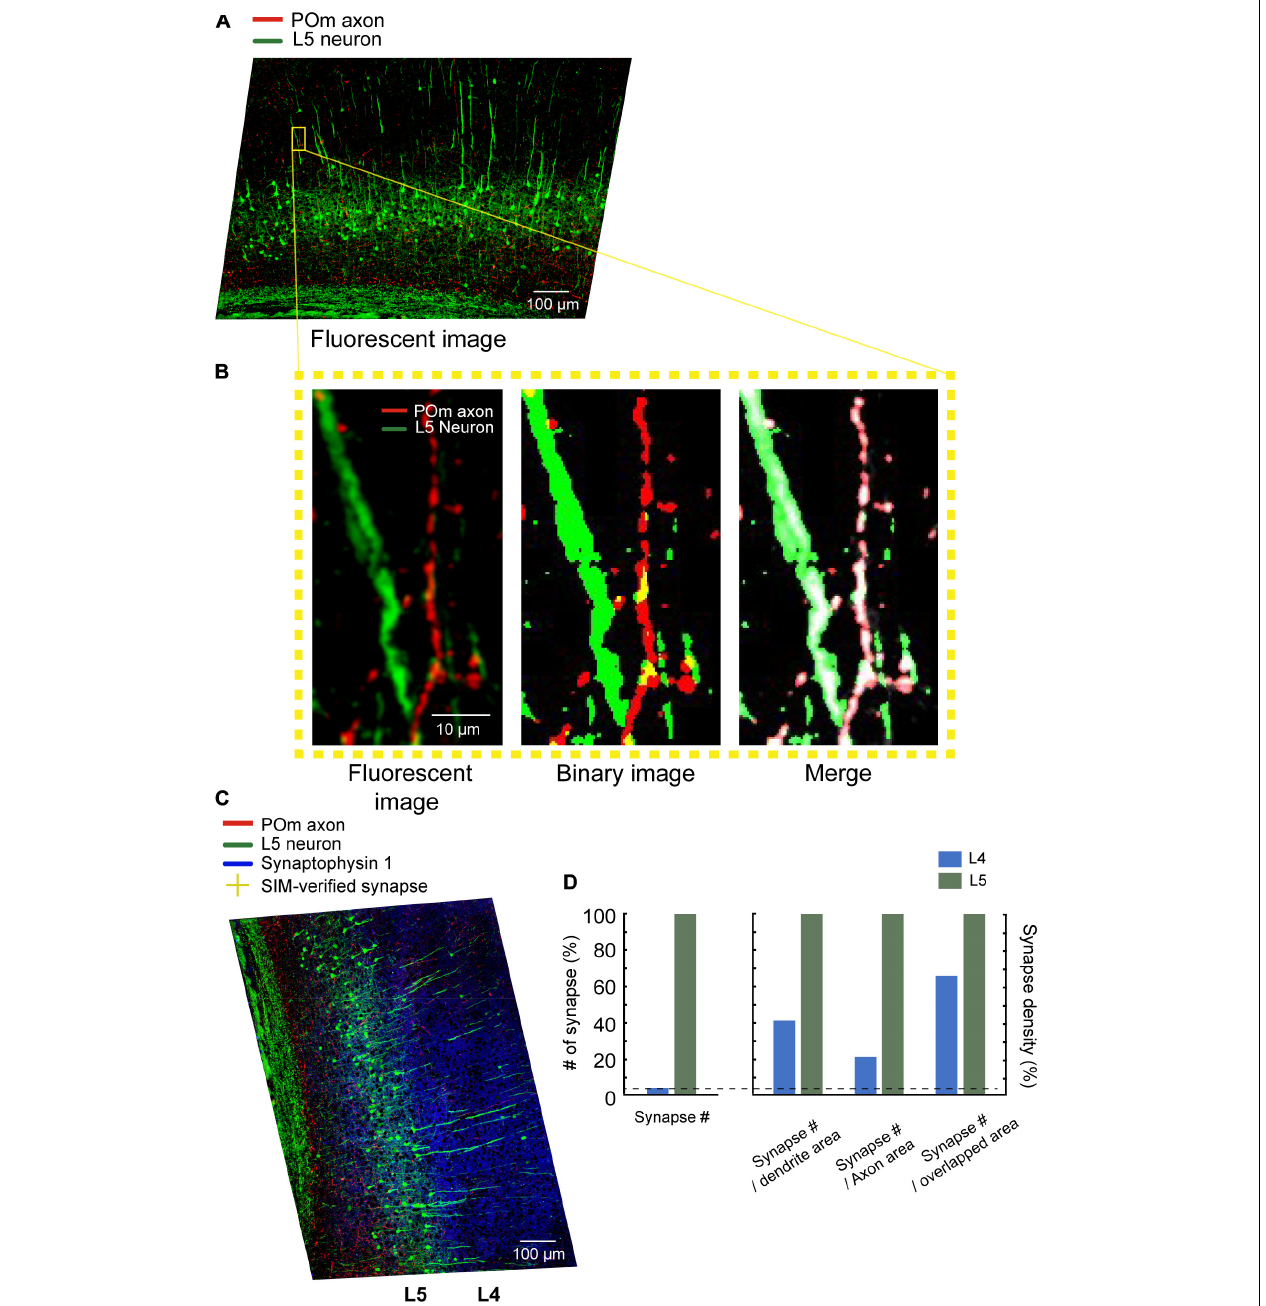
FIGURE 5 | Image segmentation and quantitative analysis. (A) Maximum intensity projected 20x images. Scale bar = 100 µ m. (B) Left: a zoomed-in image of the area indicated with a yellow box. Middle: The binarized image of the same area. Right: The overlaid original images (both channels are shown in white) with segmented axons (red) and dendrites (green). Scale bar = 10 µ m. (C) Relocated POm synapses confirmed by SIM images (yellow crosses) on the z-projected 20x image. Cortical layers were defined by the density of cell bodies, as shown by white lines. Scale bar = 100 µ m. (D) The number of POm synapses on the L5 pyramidal neurons in L4 and L5 (left). The number of POm synapses in the unit area of axons, dendrites, and the intersections